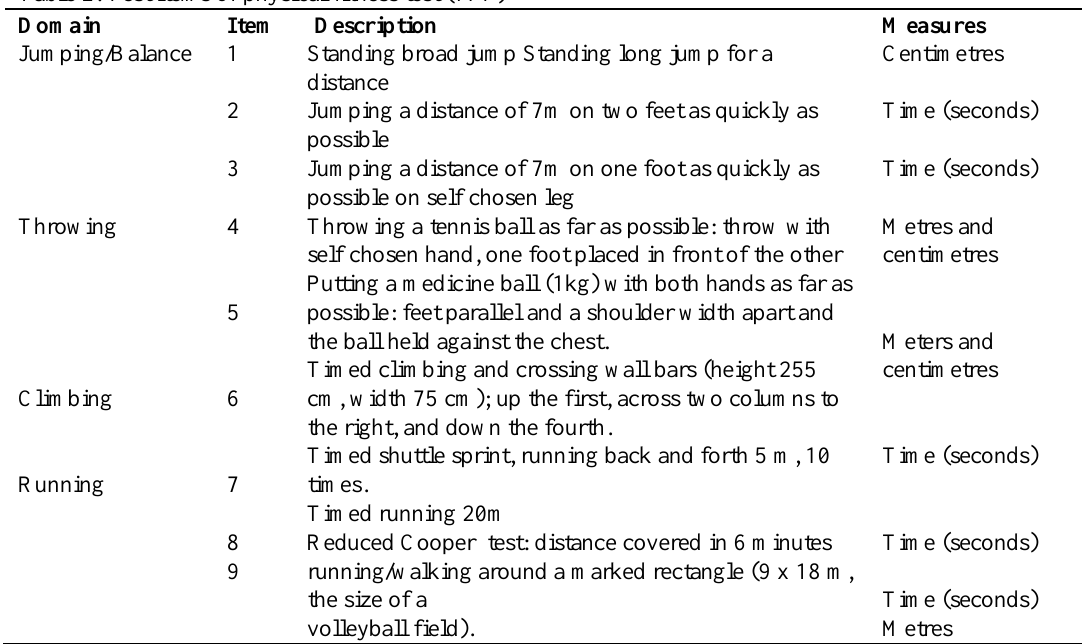
Table 2. Test items of physical fitness test